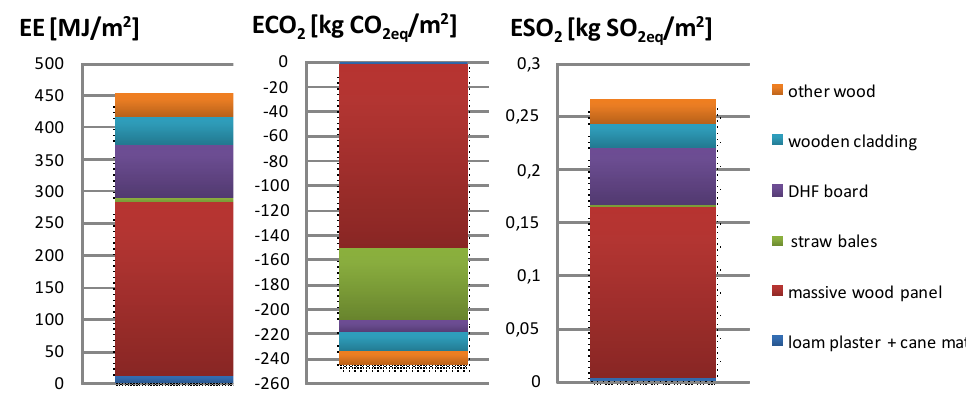
Figure 4. External walls: Materials share by percentage and impact on environmental indicators.